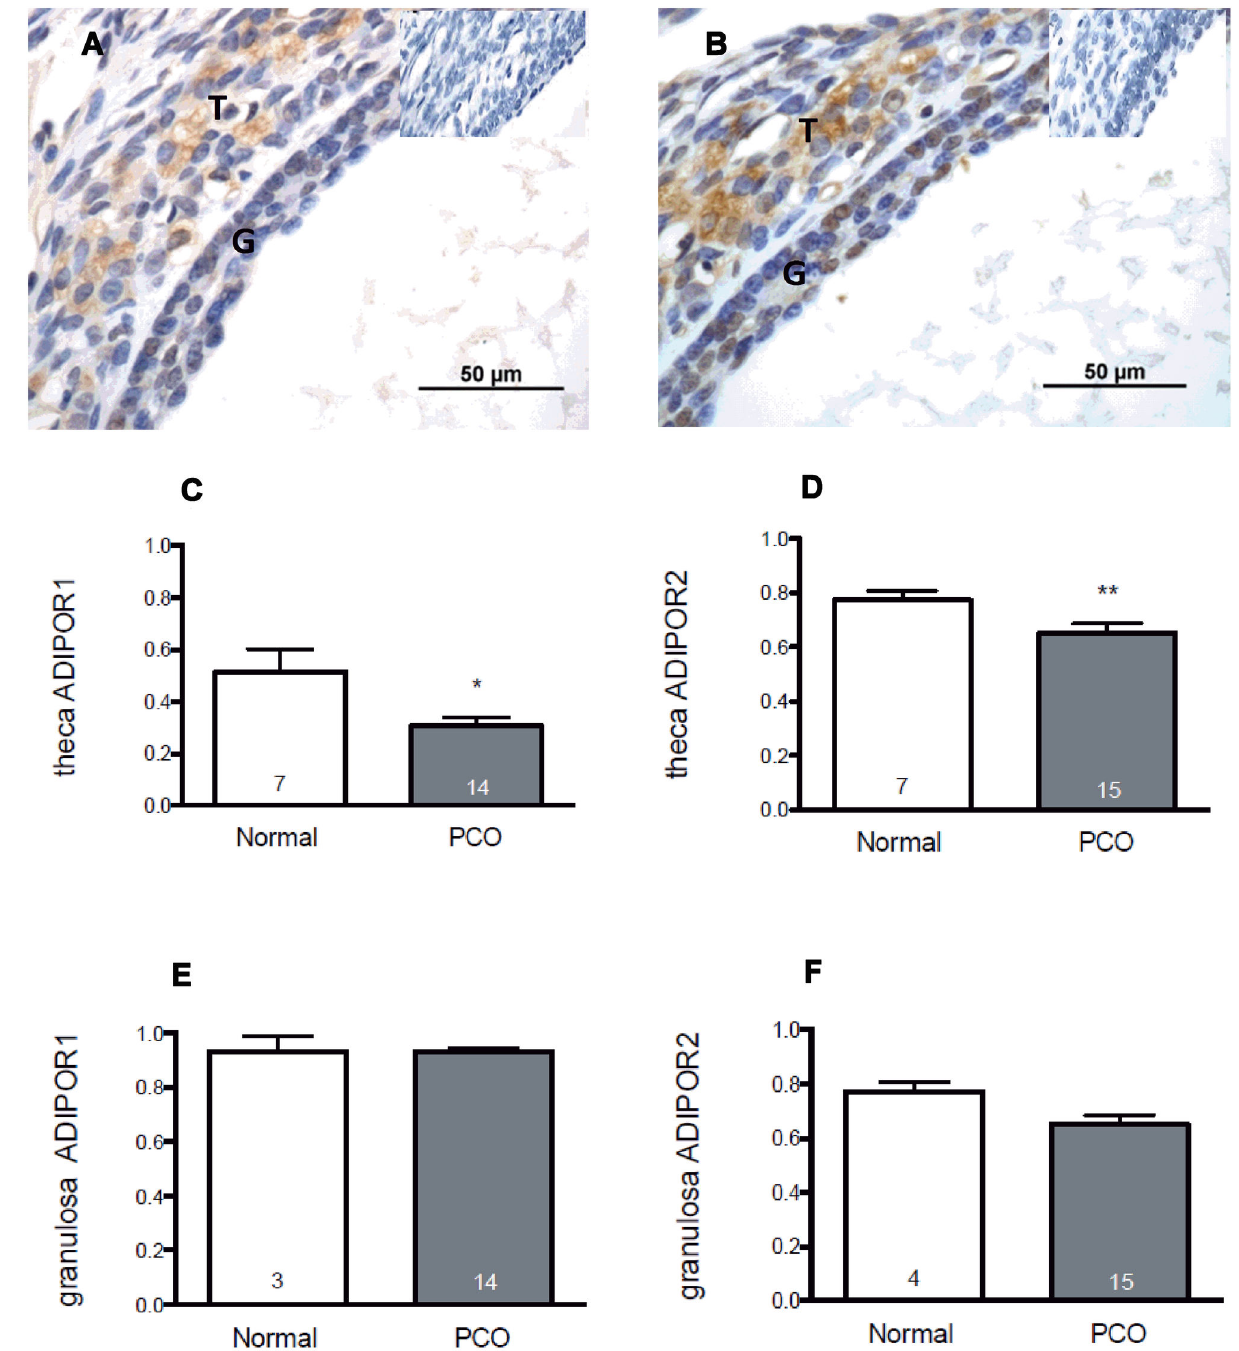
Figure 1. Expression of adiponectin receptors in follicles from normal and polycystic human ovaries. Both AdipoR1 (Figure 1a) and AdipoR2 (Figure 1b) were detected in granulosa (G) and theca (T) of antral follicles (insets show control [negative] sections). The proportions of theca and granulosa cells expressing protein for adiponectin receptor I & 2 (AdipoR1 and AdipoR2) in follicles from normal and polycystic ovaries are shown in the bar graphs. A total of 920 follicles were analysed. A significant reduction in the proportion of TCs labelled for (c) AdipoR1 and (d) AdipoR2 was demonstrated in polycystic ovaries compared with normal ovaries from healthy women (*p=0.002, **p=0.049, Mann-Whitney). No differences between PCO and control tissue were detected in the proportion of granulosa cells labelling for AdipoR1 (e) or AdipoR2 (f). Data shown are mean + SEM in up to 7 normal and 15 polycystic ovaries. doi: 10.1371/journal.pone.0080416.g001 PLOS ONE |